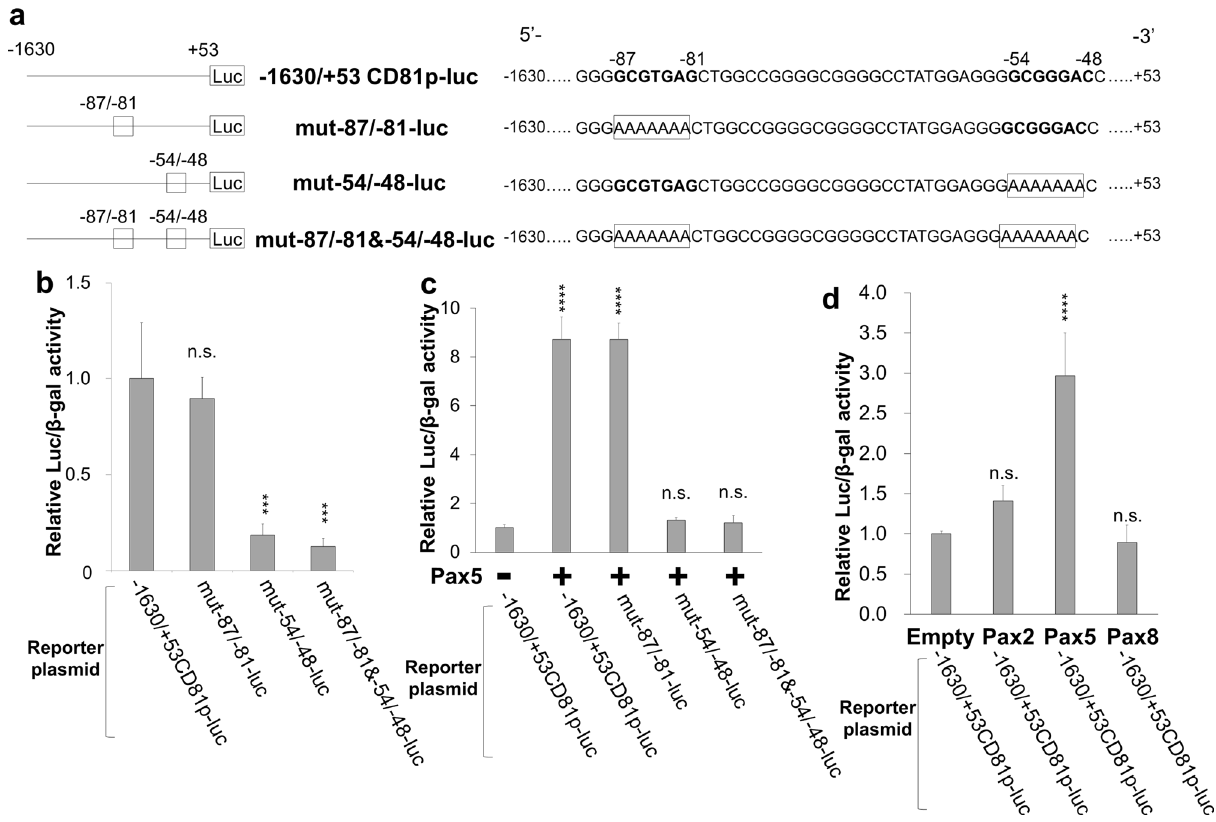
Figure 2. The Pax5 binding site, (-54)GCG GGA C(-48), in the CD81 promoter is essential for transcriptional activation. ( a ) Diagrammatic representation of − 1630/ + 53CD81p-luc and mutated reporter plasmids that were generated from − 1630/ + 53CD81p-luc. The mut-87/-81-luc, mut-54/-48-luc, and mut-87/-81&54/-48-luc have AAA AAA A-substitutions in the Pax5-binding consensus sequences, (-87)GCG TGA G(-81), (-54)GCG GGA C(-48), and both of (-87)GCG TGA G(-81) and (-54)GCG GGA C(-48), respectively. The AAA AAA A-substituted Pax5 sites in the CD81 promoter are indicated as open rectangles. ( b ) The Pax5-binding site, (-54)GCG GGA C(-48), is essential for CD81 promoter activity. ME180 cells were transfected with the − 1630/ + 53CD81p-luc reporter plasmid or its mutant along with pSV-β-gal. After 24 h, cells were harvested, and luciferase and β-gal activities were measured. The luciferase/β-gal activity of − 1630/ + 53CD81p-luc was defined as 1.0. ( c ) The Pax5 is the transcription factor responsible for CD81 promoter activation. HeLa cells were co-transfected with Pax5- pCIneo and − 1630/ + 53CD81p-luc (or its mutant) plasmids and cultured for 24 h. The luciferase/β-gal activity of − 1630/ + 53CD81p-luc without Pax5 was defined as 1.0. The mean ± SD are from three different experiments. ( d ) The activating effects of Pax5, Pax2 and Pax8 on CD81 promoter in B cell. BC3 cells were co-transfected with − 1630/ + 53CD81p-luc and Pax expression plasmid and cultured for 24 h. The firefly luciferase/β-gal activity of − 1630/ + 53CD81p-luc without Pax was defined as